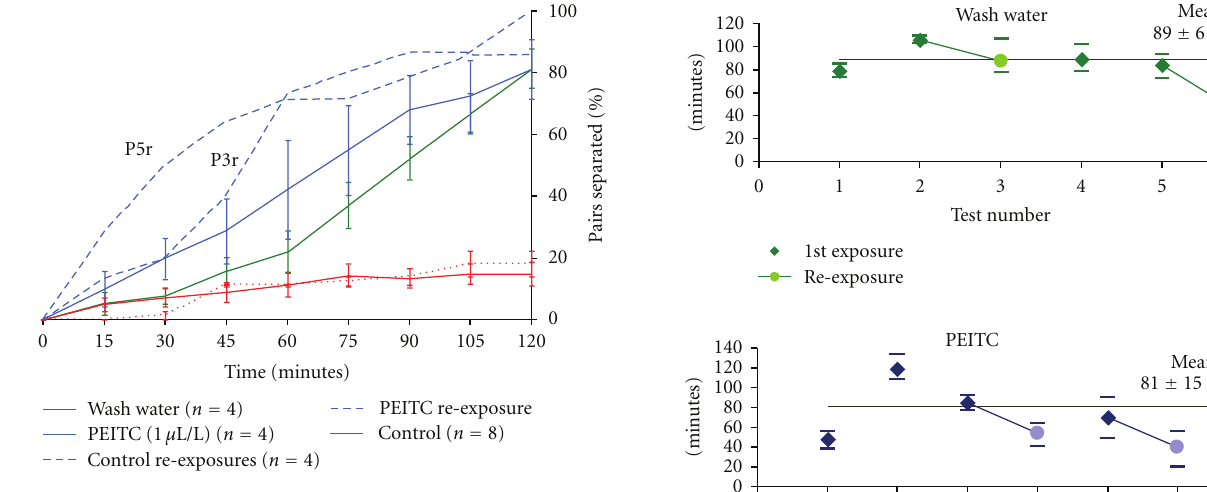
Figure 3: Cumulative proportion of pairs separated-PEITC re- exposures. Solid lines show the mean response for four separate initial exposures. The initial PEITC exposure (blue) is emboldened for comparison with re-exposures (blue-dotted lines) to PEITC on 2 separate test occasions; Test P5r (14 pairs) after exposed test organismshad spent 24h in clean water, and Test P3r (15 pairs) after exposed test organisms had spent 48h in clean water. The mean response of 4 control re-exposures (red) follows a similar pattern to the initial control exposure (red-dotted line shows the mean of 8 control exposures). Vertical bars show standard error; n denotes the number of tests.